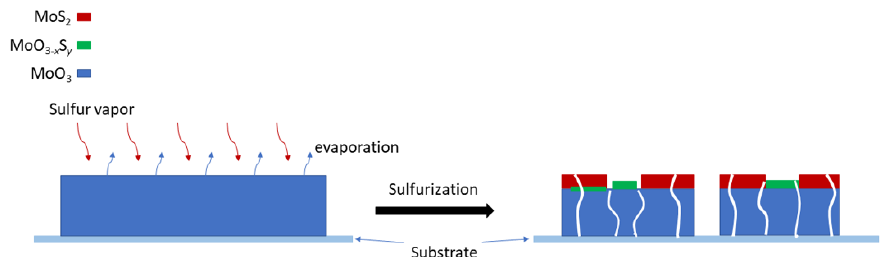
Figure 6. A schematic diagram illustrating the sulfurization process of MoO 3 nanoribbons.